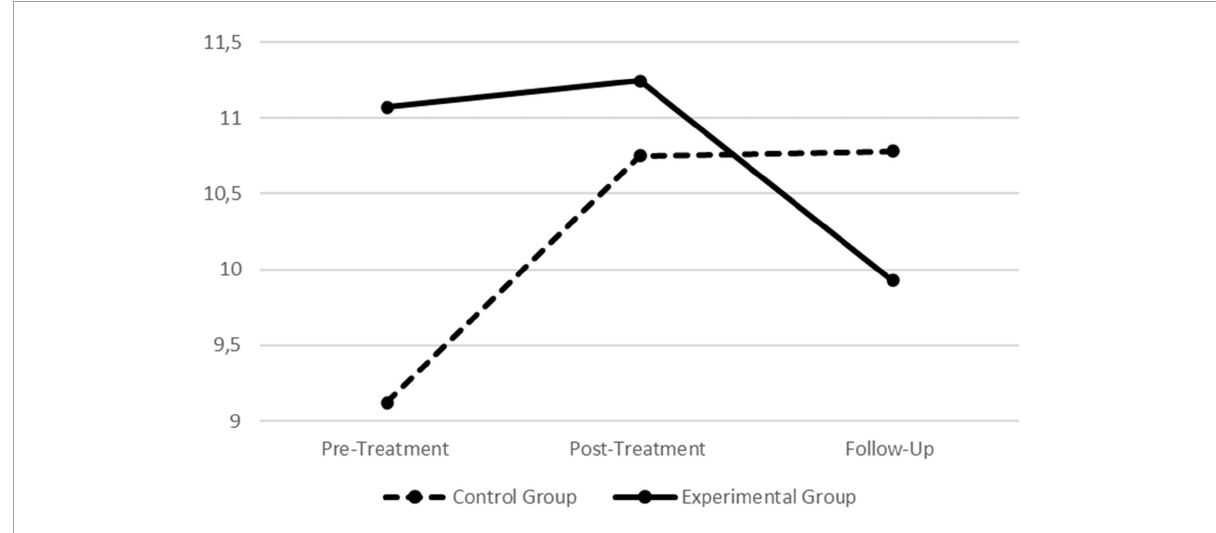
FIGURE7 Graphic presentation of group differences in the Difficulties in Emotion Regulation Scale–Adolescent Version (DERS-AV) clarity subscale across the pre- treatment, post-treatment, and follow-up assessment